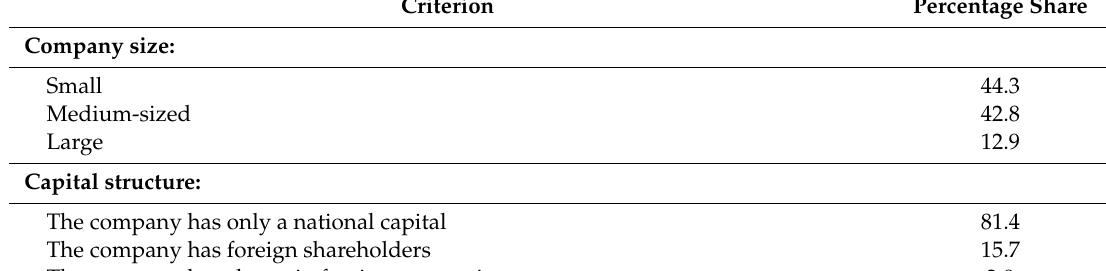
Table 1. Structure of surveyed business entities (n =